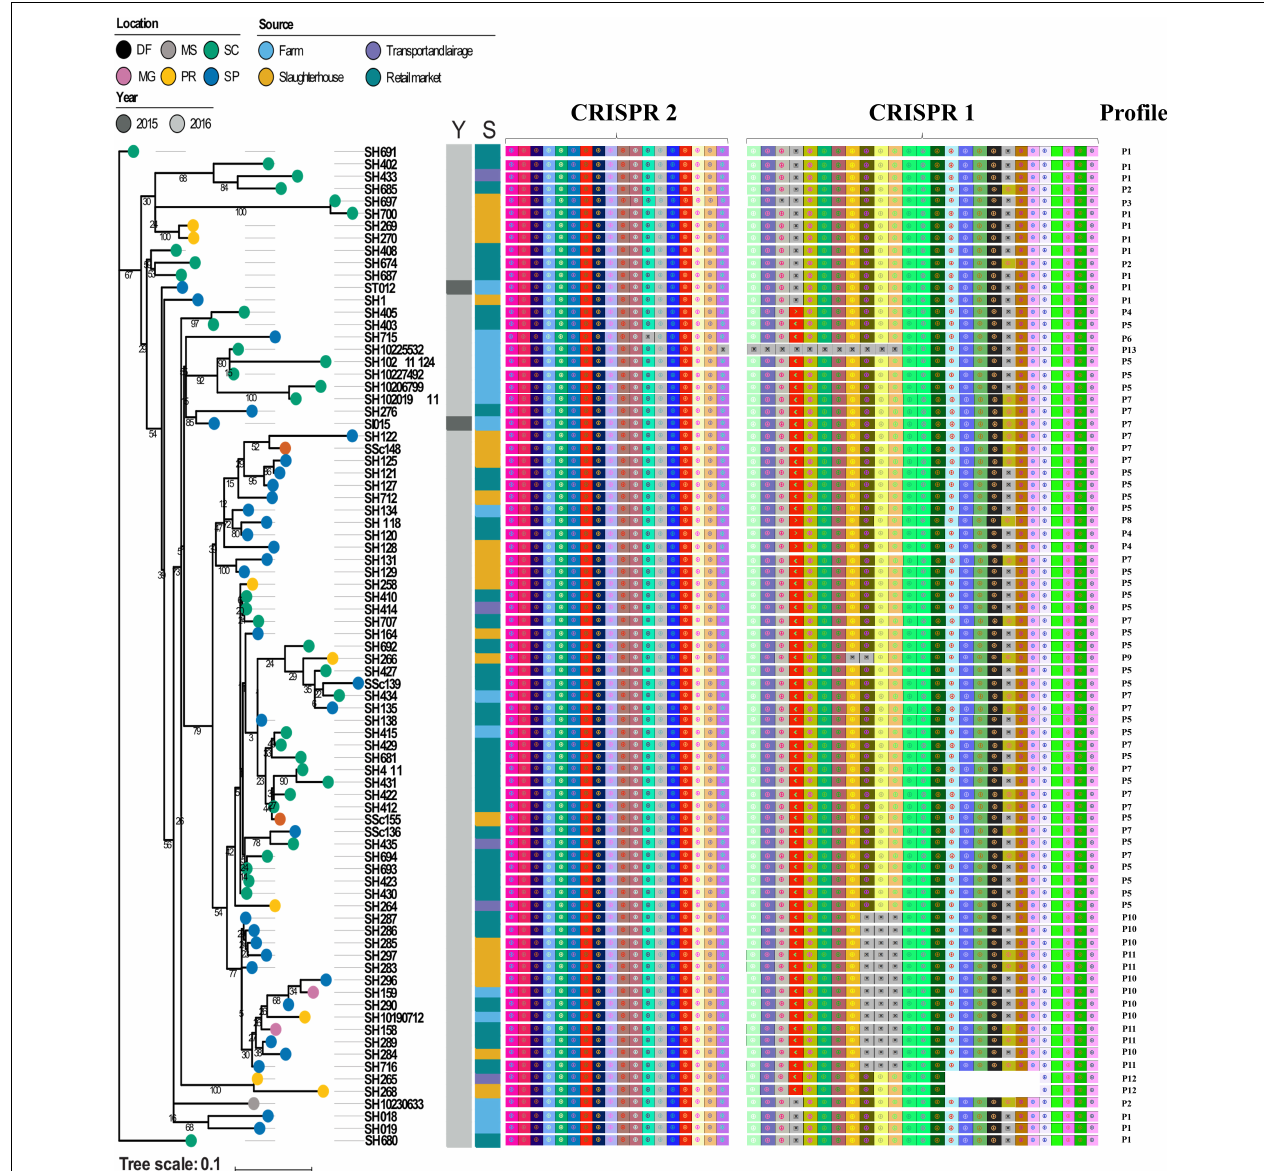
FIGURE 2 | Reconstructed phylogeny based on the core genome, distribution of spacers composition, clustered regularly interspaced short palindromic repeats (CRISPR) loci, and CRISPR profiles among Salmonella Heidelberg strains. The location of isolation of each strain is labeled on its respective branch. Color strips depict the year (Y) and source (S) of isolation, respectively. Brazilian States: PR, Paraná; SC, Santa Catarina; SP, São Paulo; MG, Minas Gerais; DF, Distrito Federal; MS, Mato Grosso do Sul.